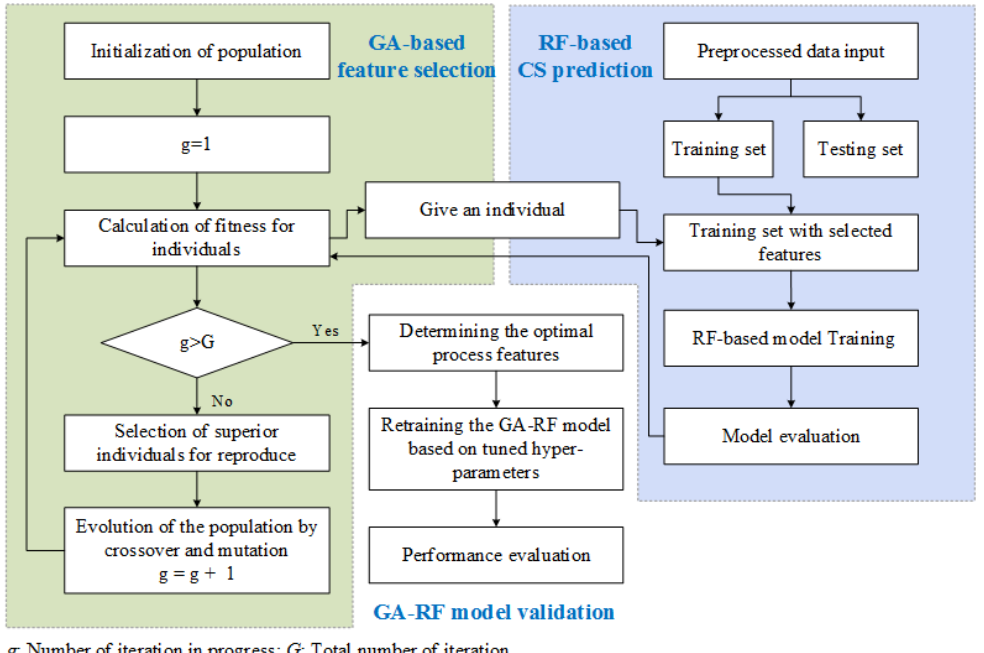
Figure 1. Flowchart of genetic algorithm-random forest (GA-RF) for the compressive strength (CS)